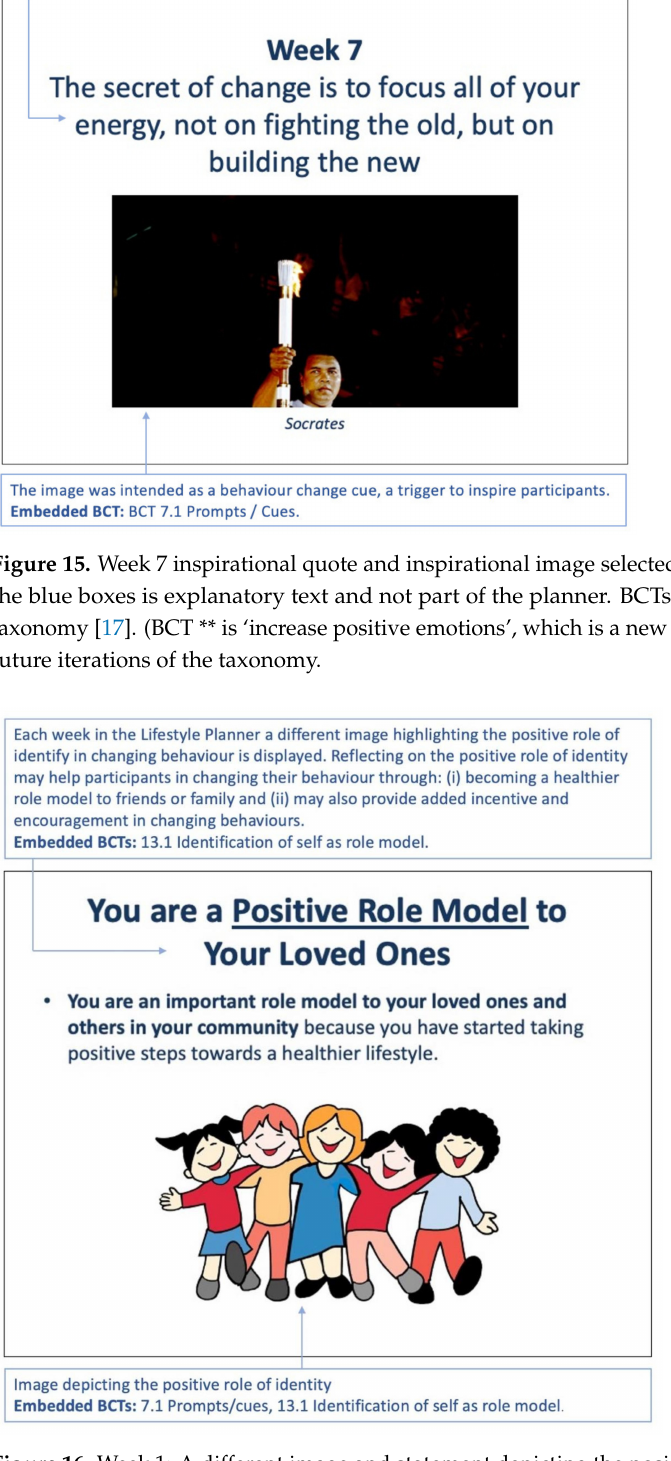
Figure 16. Week 1: A different image and statement depicting the positive role of identity in changing behaviour are shown each week. The text in the blue boxes is explanatory text and not part of the planner. The BCTs used, refer to the Michie et al. taxonomy